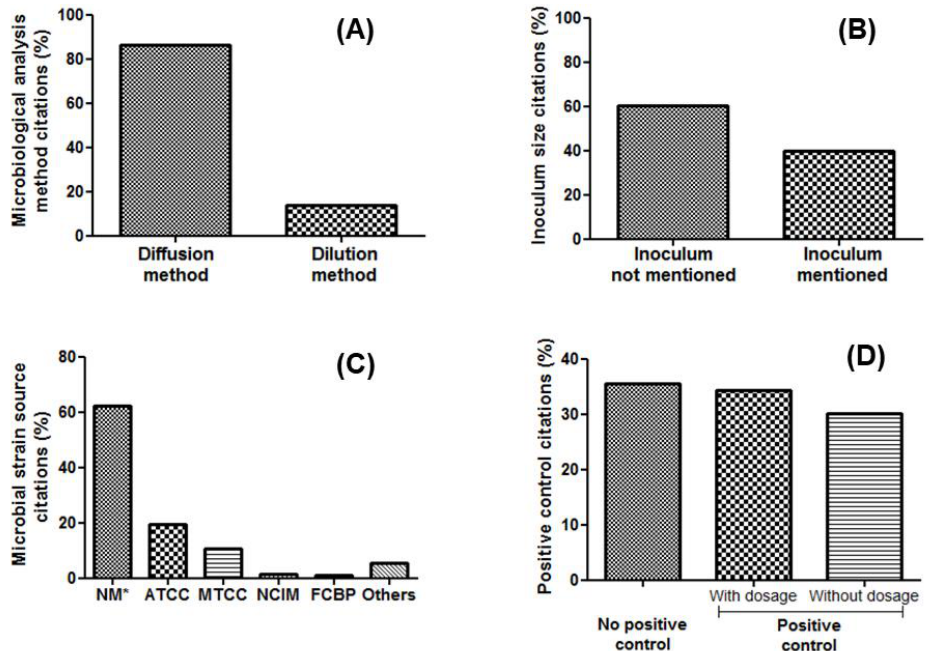
Figure 8. ( A ) Percentage of microbiological analysis citations ( n = 635). ( B ) Percentage of inoculum size citations ( n = 635). ( C ) Percentage of microbial strain source citations ( n = 2391). Others (5.4%) include CMCC (China Medical Culture Collection), KACC (Korean Agricultural Culture Collection), KCCM (Korean Culture Center of Microorganisms) and PTCC (Persian Type Culture Collection) (*NM = not mentioned). ( D ) Percentage of positive control citations ( n = 752).